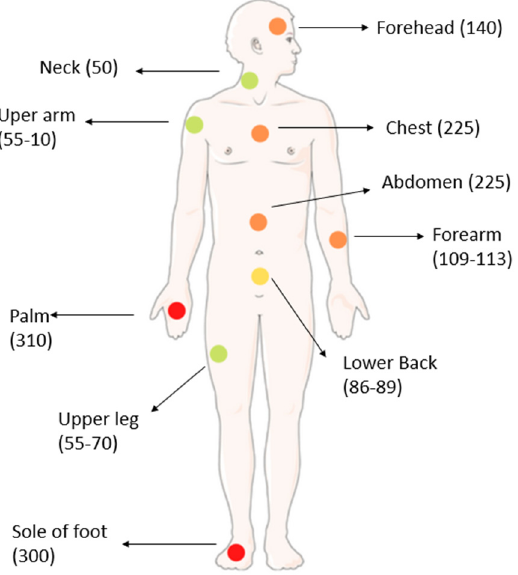
Figure 2. Average sweat gland density (glands/cm 2 ) on various regions of the body [44].